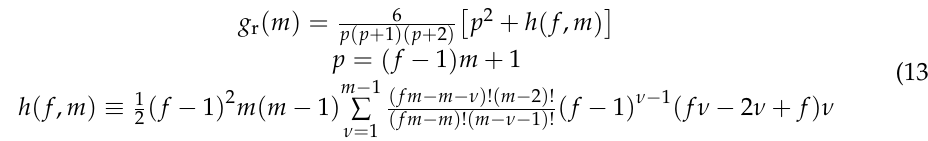
Arrows in Figure 6 indicate the theoretical g -factors g r ( m ) for the random-type branch- ing, calculated by Equation (13) with f = 4 and different m = 1–20. When three (six) PUL-OSA chains with degree of polymerization = 1510 form a trimer (hexamer), N 0 is equal to 4530 (9060), where the experimental g values for PDS20 and PDS30 in Figure 6 are close to g r ( m ) at m = 2 (5) indicated by the arrow. It is reasonable that the number of branch points with f = 4 is equal to the aggregation number minus unity. (For example, a randomly aggregating dimer has a single branch